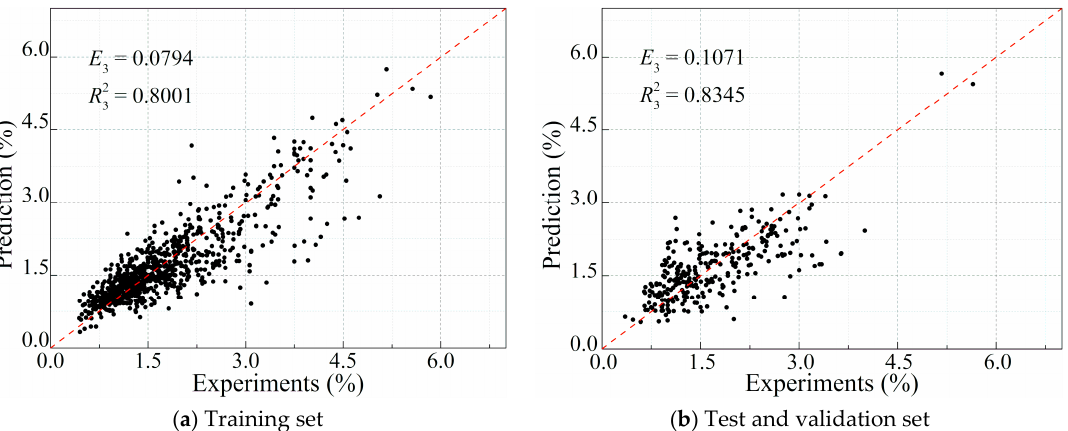
Figure 9. Comparison results of the ultimate drift between the experimental, ANN model and explicit methods.